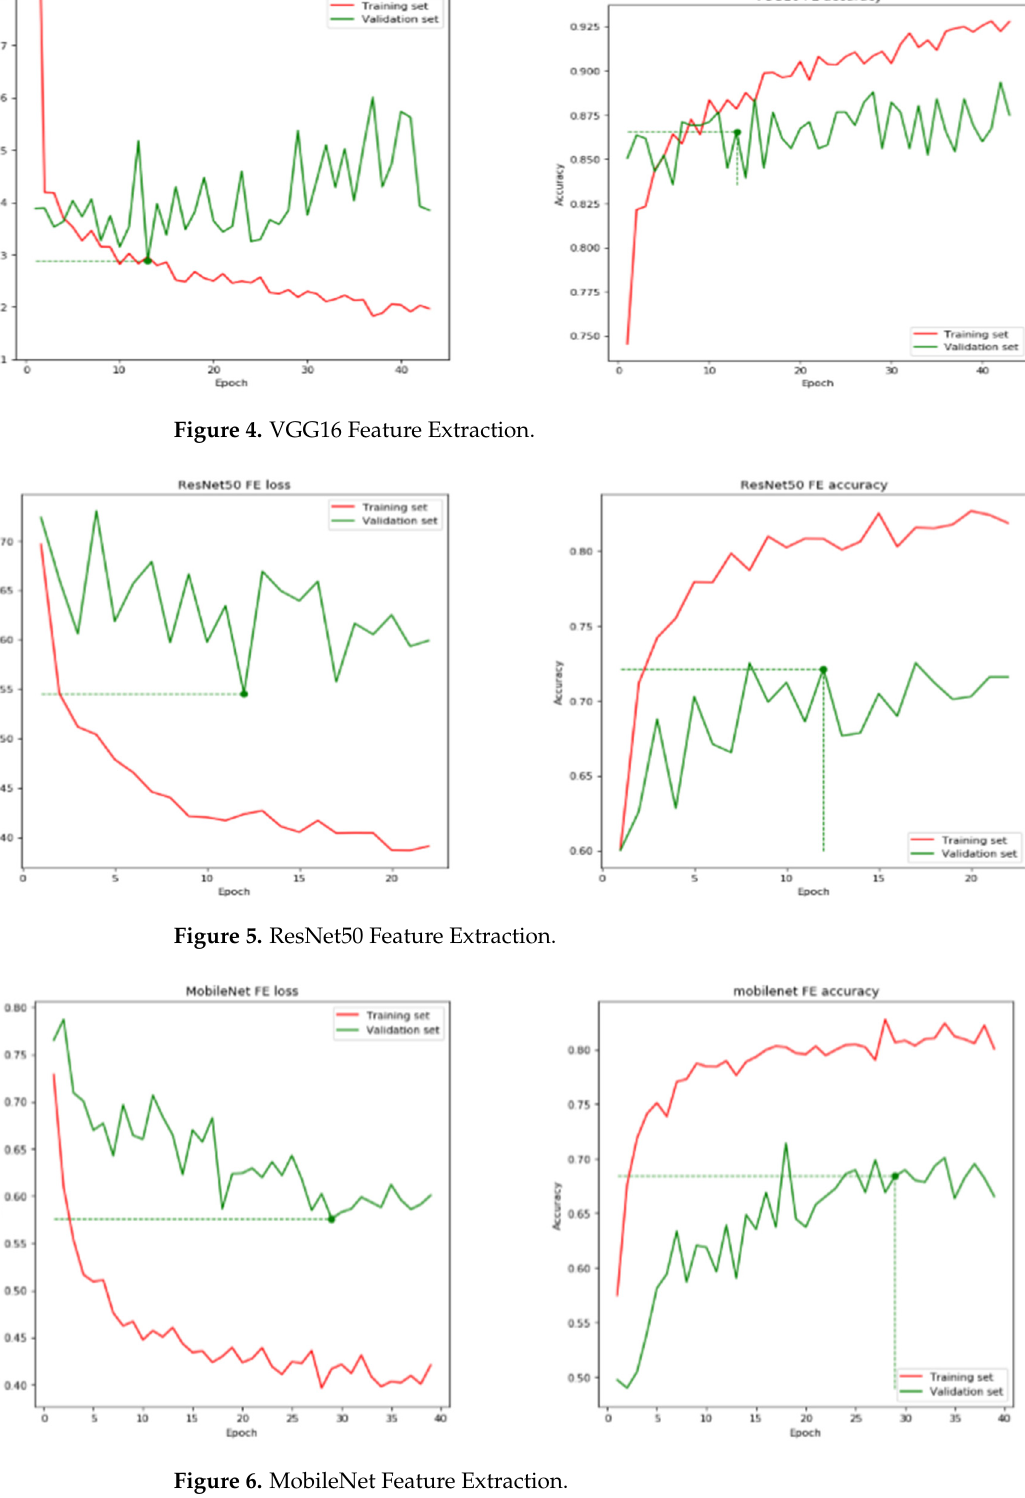
Figure 7. CoroNet Feature Extraction. 5. Conclusions Deep convolutional neural networks (CNNs) are frequently used for medical image analysis, Unlike the randomly initialized ones, pre-trained natural image database (ImageNet)-based CNN models have a better chance of being successfully fine-tuned to produce better results than those that are randomly initialized. A CNN model called Cor- oNet is suggested to perform the automatic detection of BC by the CBIS-DDSM dataset. It leverages the Xception architecture, which was completely trained on whole-image BC based on mammograms, and pre-trained on the ImageNet dataset. This paper proved that the convolutional design method “CoroNet” outperforms its alternative networks. In four-class classification, experiments demonstrate that it can achieve an overall accuracy of 94.92 percent (benign mass vs. malignant mass and benign calcification vs. malignant calcification). For the two-class examples, CoroNet has a classification accuracy of 86.67%. (calcifications and masses). High-resolution mammography handling is seen as a significant difficulty. In order to see the fine features contained in these high-resolution mammograms, the models must also be updated. Although there are various imaging modalities that can be employed, such as MRI and ultrasound, the majority of the current CAD relies on X-ray mammogra- phy. The use of 3D mammograms for diagnosis rather than 2D mammograms is another difficult issue that necessitated research in order to make the most of the 3D property, and to improve detection and classification performance.